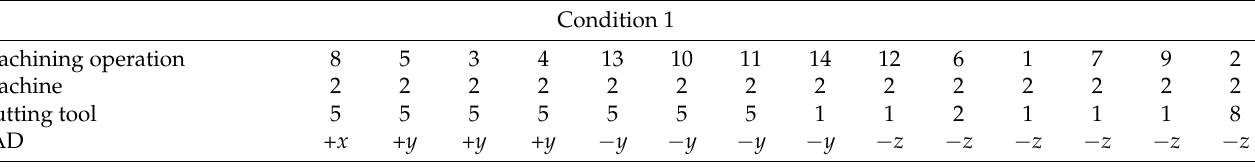
Table 10. Optimal process plans for prismatic part 2 for two conditions.